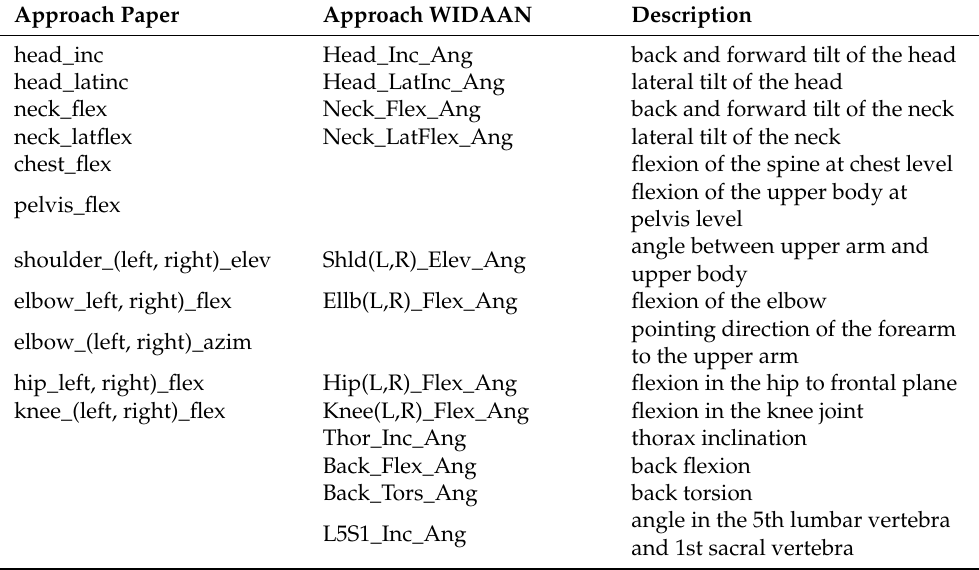
Table 4. Naming of the joint angles, examined using the approach in this paper, and the corresponding joint angles calculated by